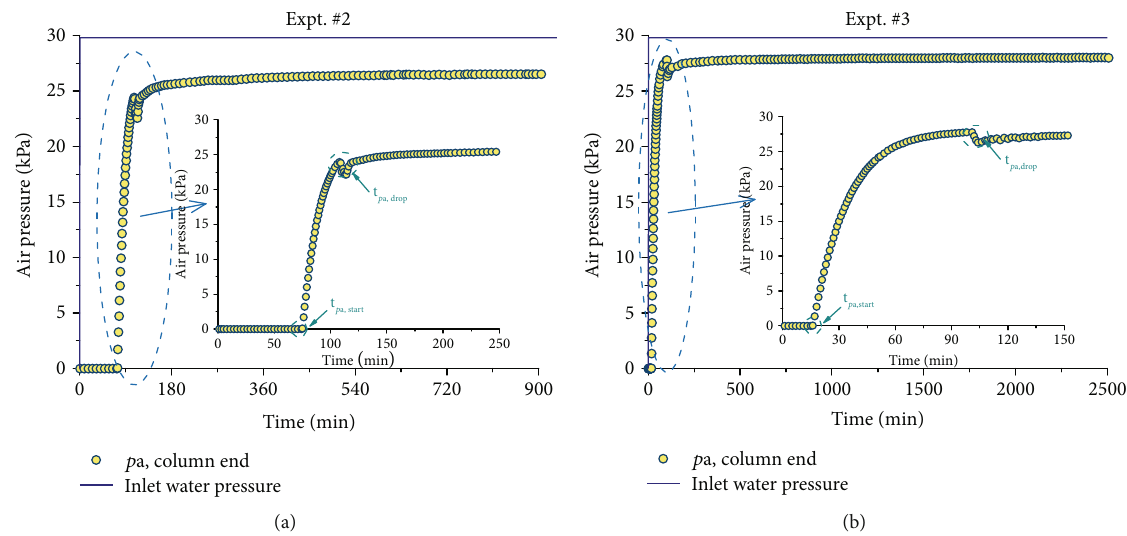
Figure 4: The variation in air pressure with time at the column end for (a) Expt. #2 and (b) Expt. #3, shown at two time